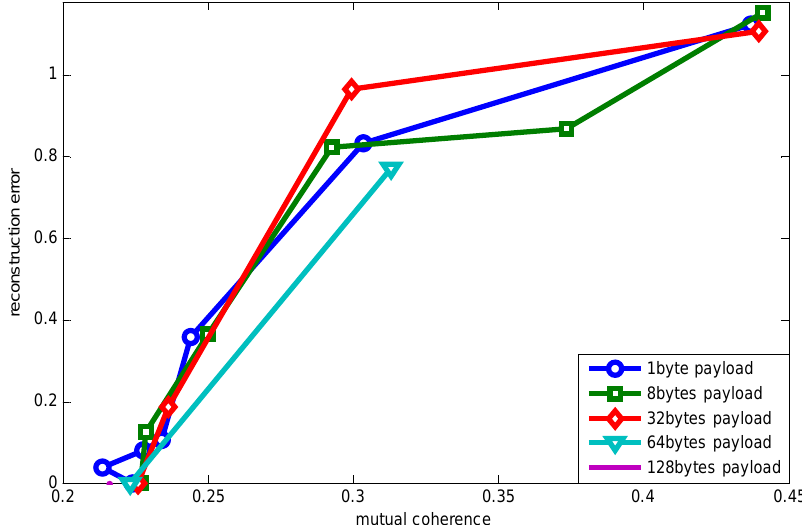
Figure 11. Relationship between mutual coherence and reconstruction error using RCS projection with